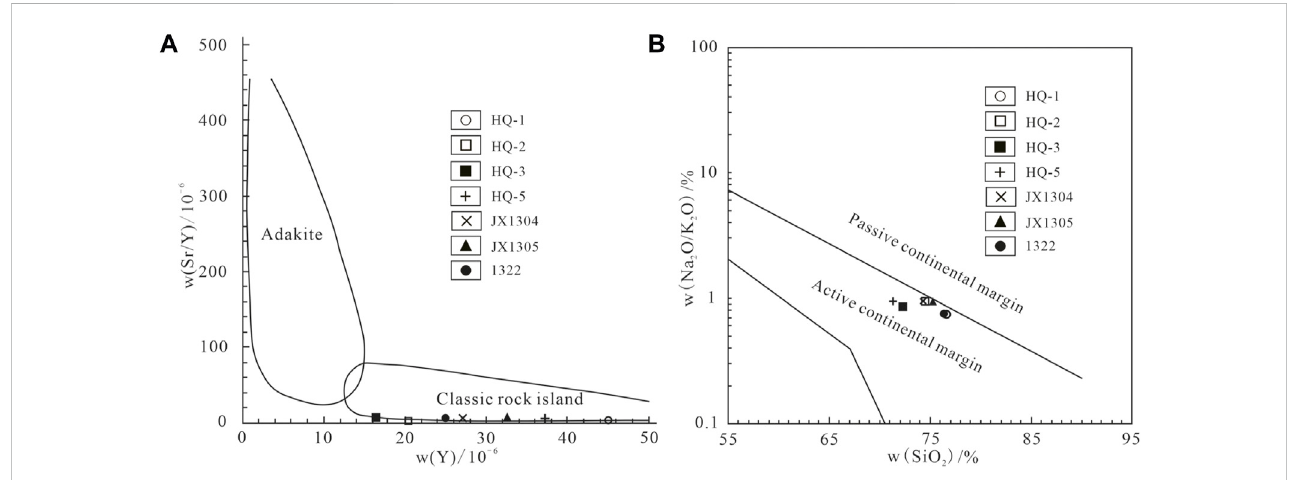
FIGURE 13 Sr/Y-Y (A) and Na 2 O/K 2 O-SiO 2 (B) tectonic discrimination diagrams of granites in the Xinchenggou area, Dongning County (A after Defant and Drummond, 1990; B after Roser and Korsch,